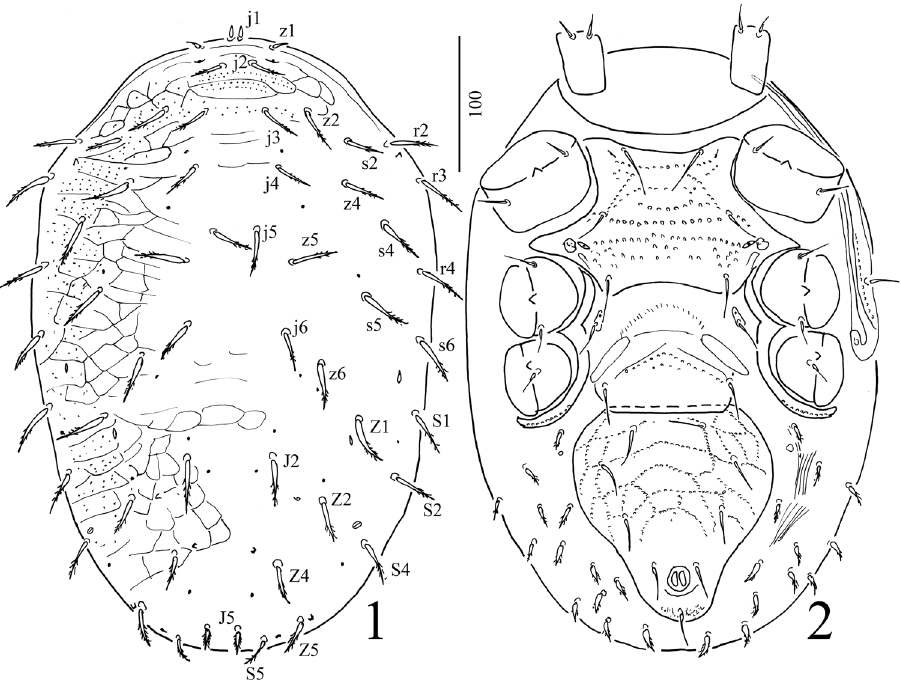
Figures 1–2. Macrocheles kekensis sp. n., female. 1 Dorsal view of body 2 Ventral view of body (without legs and gnathosoma, only the coxae